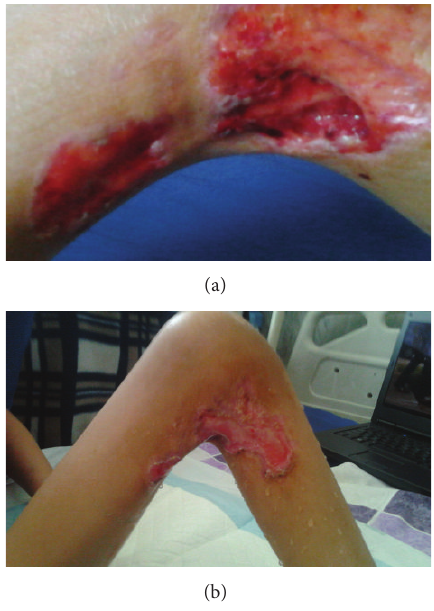
Figure 1: Skin lesion in the left knee in our patients with Sweet’s syndrome: (a) acute phase, (b) after 7